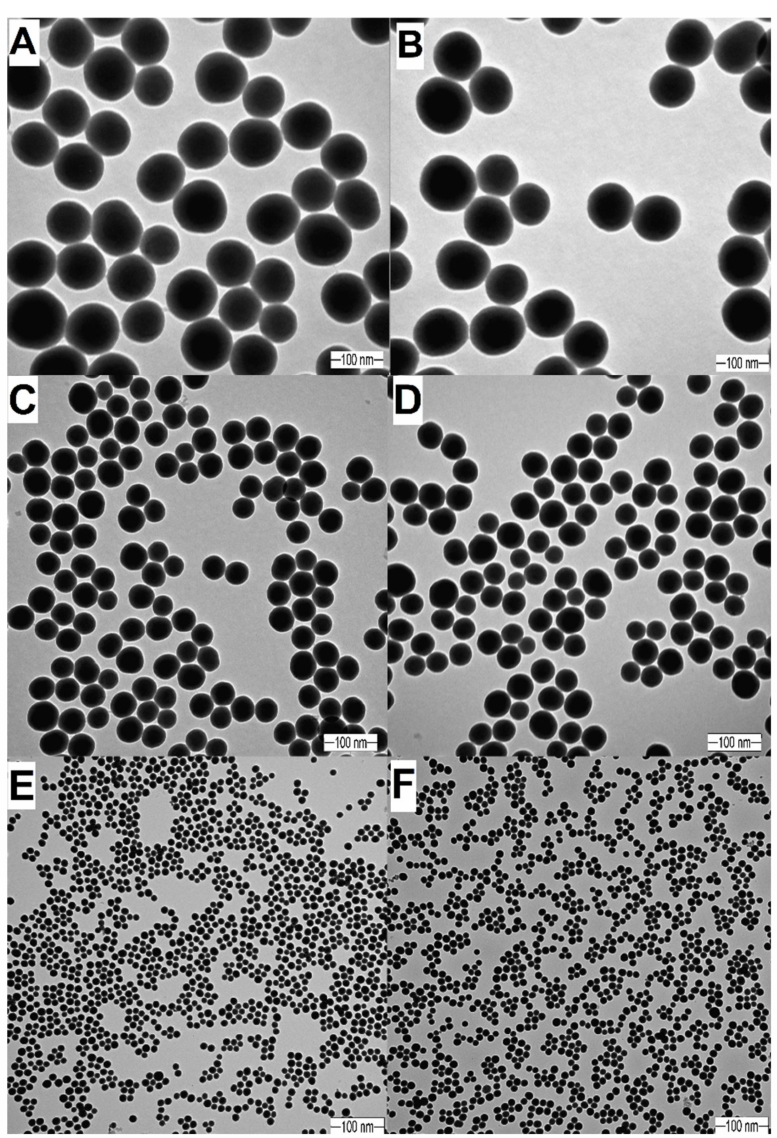
Figure 1. TEM images of silica nanoparticles (SNPs). ( A ): HS100, d = 103.0 nm. ( B ): ET100, d = 110.7 nm. ( C ): HS50, d = 53.0 nm. ( D ): ET50, d = 55.0 nm. ( E ): HS20, d = 20.0 nm. ( F ): ET20, d = 20.0